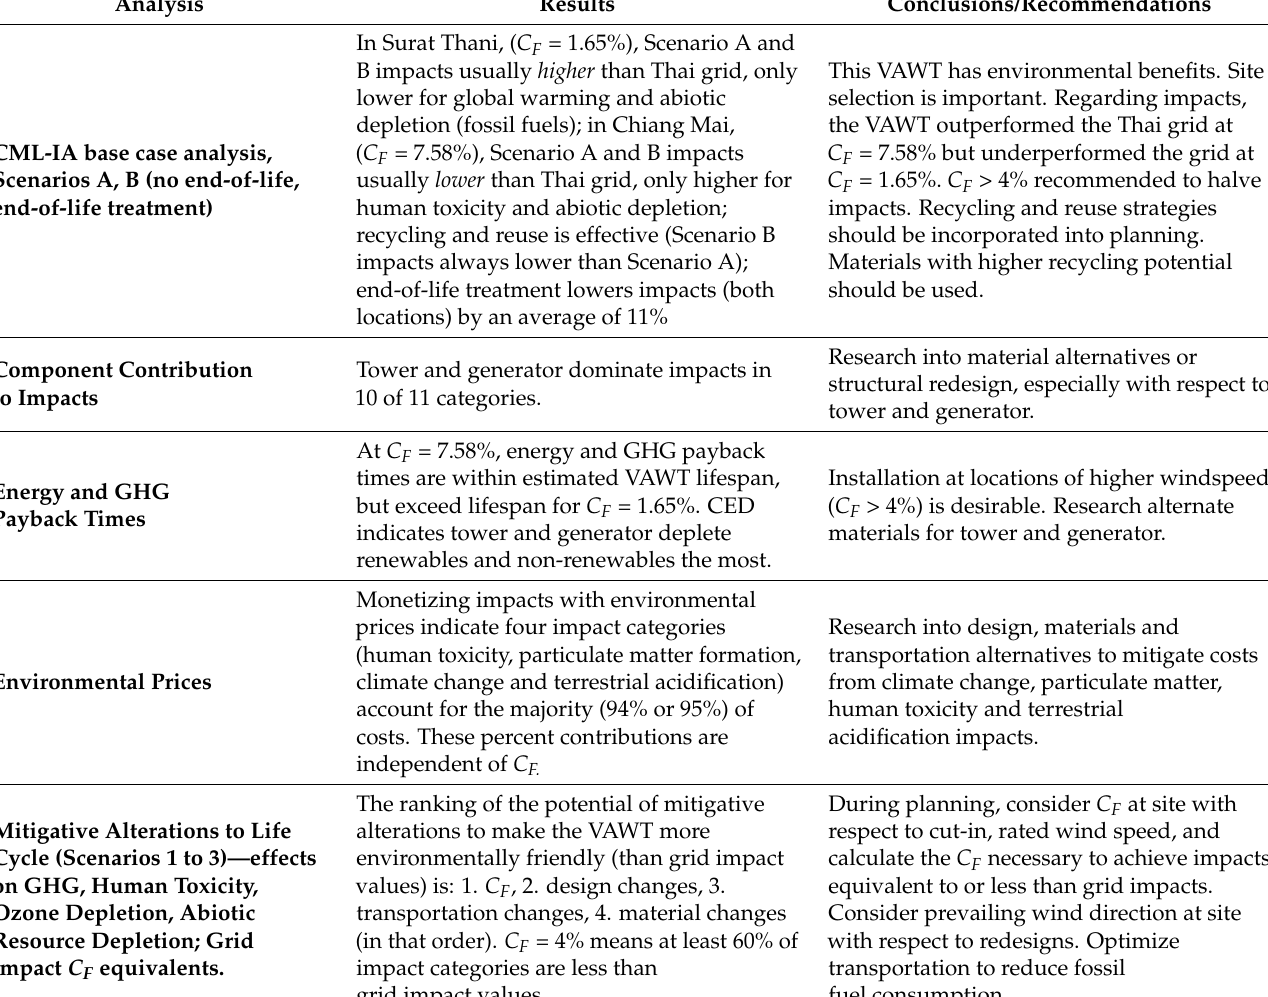
Table 13. Summary of life cycle analyses, results and